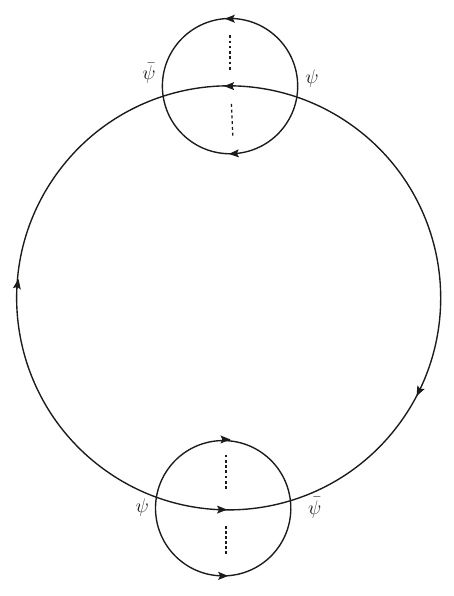
Figure 3 . Two loop contribution to free